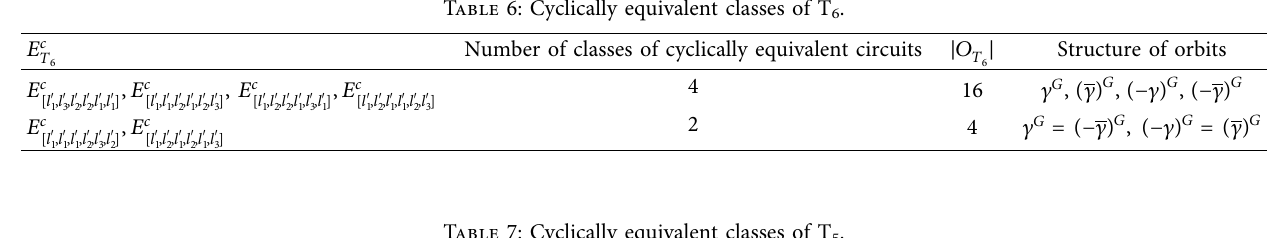
Table 6: Cyclically equivalent classes of T